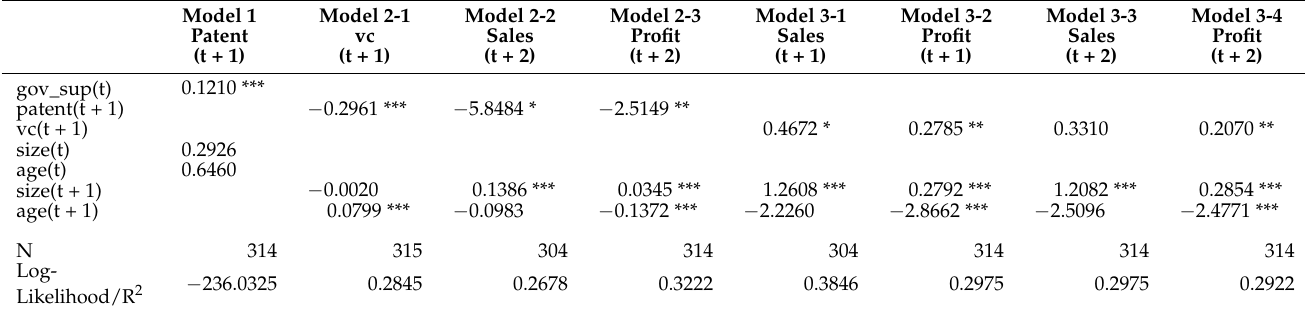
Table 4. Results of regression